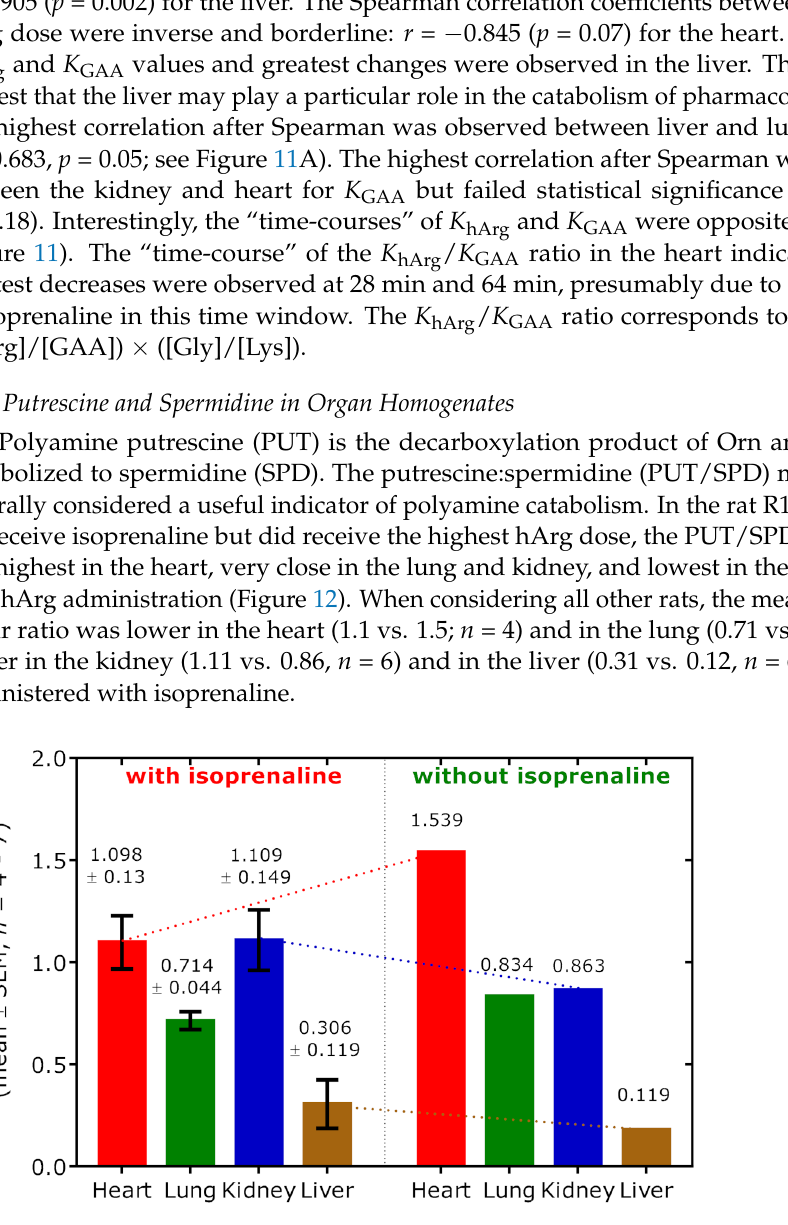
Figure 12. Putrescine-to-spermidine molar ratio in the organs of the rats administered with isopre- naline ( left panel ) and in a rat (R17) that did not receive isoprenaline ( right panel ). The rats received various doses of hArg. R17 received an hArg dose of 440 mg/kg. See also Table